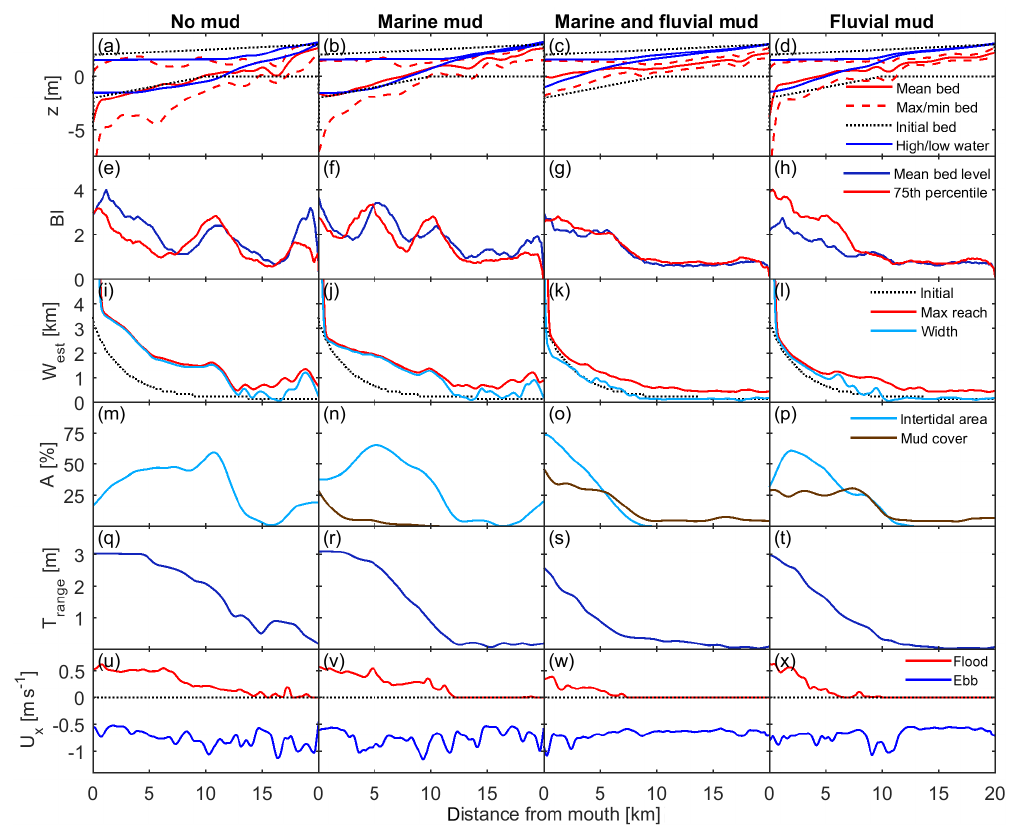
Figure A2. Hydrodynamics and morphology along estuaries with different mud sources after 2000 years. From left to right (columns): model with only sand (03), marine mud supply (02), supply from both boundaries (04) and fluvial supply (default, 01). (a–d) Minimum, mean and maximum bed elevation, high and low water level and minimum and maximum initial bed level, (e–h) braiding index and (i–l) estuary width defined as the initial width, maximum reach over the whole scenario run, the width of wet cells in the model, width defined by a threshold value that is used to mask the cells that are around the dry–wet cell threshold. (m–p) Intertidal area and mud cover as a percentage of the total area, (q–t) tidal range and (u–x) peak ebb and flood